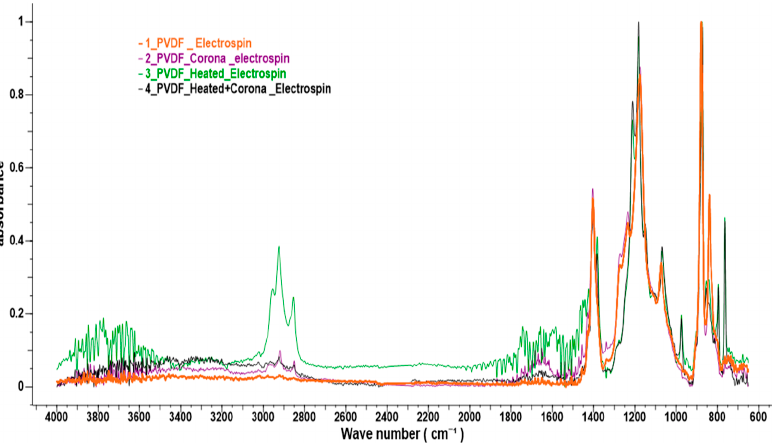
Figure 6. Comparison of FTIR spectrum of a pristine PVDF, Heat treated PVDF, and Plasma treated PVDF nanofiber samples.